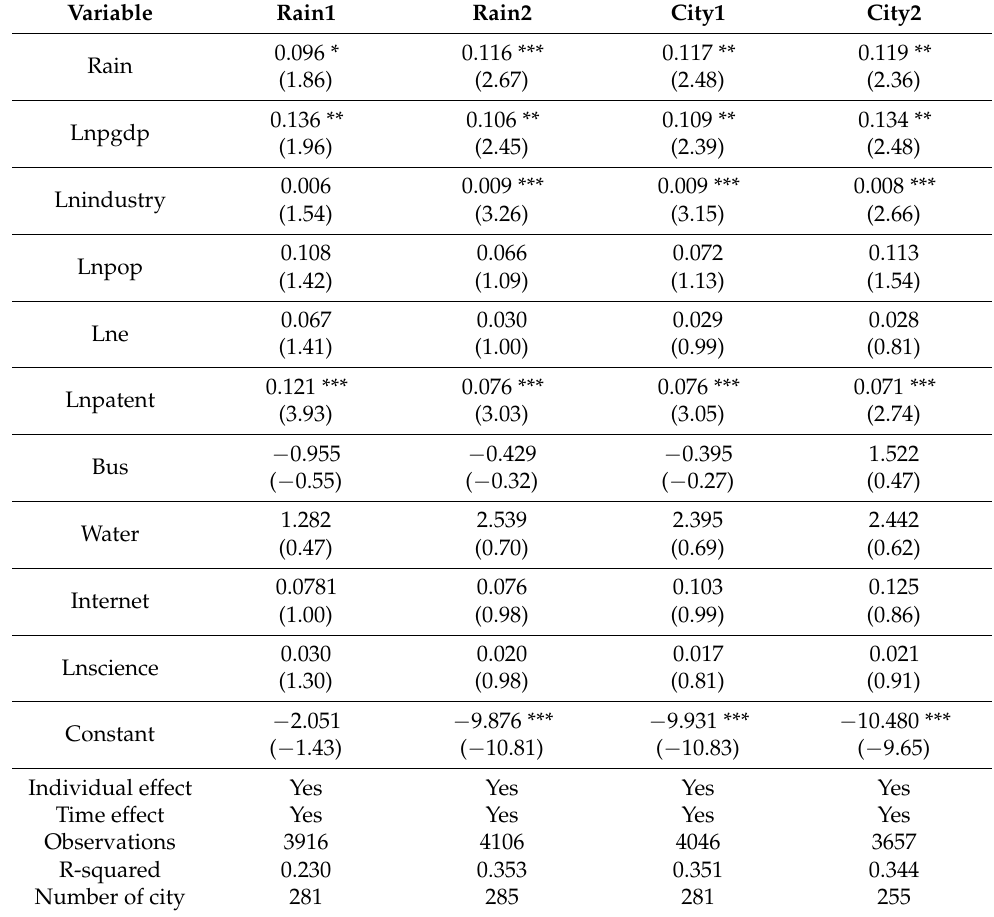
Table 3. Robustness test